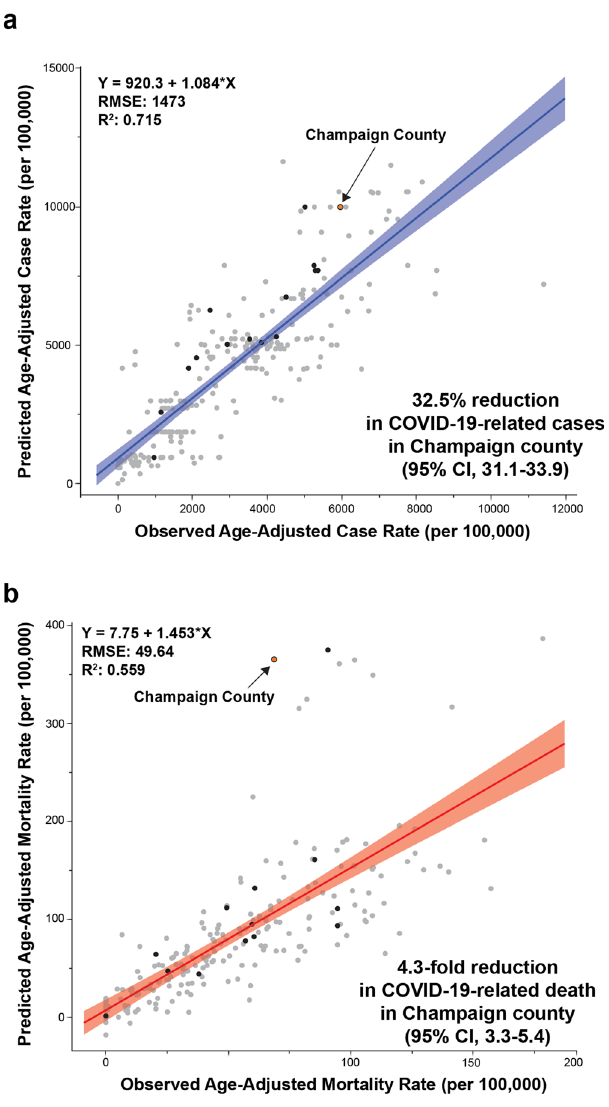
Fig. 7 Other communities without SHIELD. a and b Relationship between observed and predicted COVID-19 cases and mortality among counties with large university enrollments (student enrollment > 15,000 at start of Fall 2020 semester, n = 251). Predicted COVID-19 case and mortality rates were analyzed with a 3-week lag (to adjust for delays between exposure and outcome) using each county ’ s social vulnerability index (SVI) and age- adjusted COVID-19 mortality, accounting for state (due to policy differences in COVID-19 management). COVID-19 human case data 63,64 and SVI were provided from CDC (2021) and population data was provided from the U.S. Census Bureau (2019) 64 . The lines indicate the fi t lines for the linear regressions, with shaded areas indicating the 95% con fi dence intervals around the fi ts and circles indicating observations with Champaign County shown in orange and other Big 10 Conference Universities ( n = 16*) in black. *Hennepin and Ramsey Counties (MN) were both used for University of